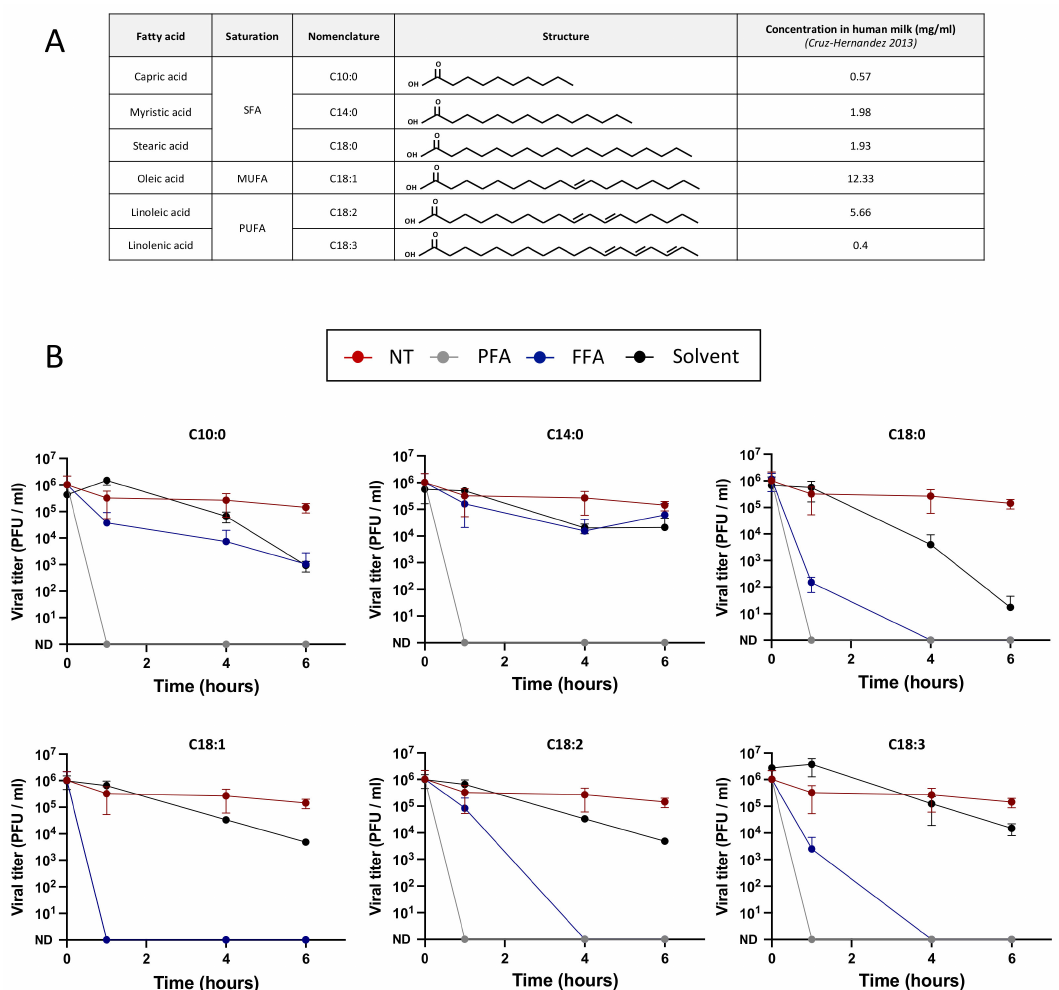
Figure 6. Free fatty acids are antiviral against ZIKV. ( A ): The fatty acids tested are either saturated fatty acids (SFA), mono-unsaturated fatty acids (MUFA), or polyunsaturated fatty acids (PUFA). Their nomenclature, structure, and abundance in human milk at 4 weeks after delivery (Cruz-Hernandez, 2013) are listed in the table. ( B ): To determine whether free fatty acids exert antiviral activity, 10 6 PFU of ZIKV particles (Brazil/2016) were incubated with culture medium (NT), paraformaldehyde 4% (PFA), free fatty acids (FFA), or the solvent used to dilute them (solvent) for 6 h. At several time points (0 h, 1 h, 4 h, and 6 h), the viral titers were determined by plaque assays ( n =